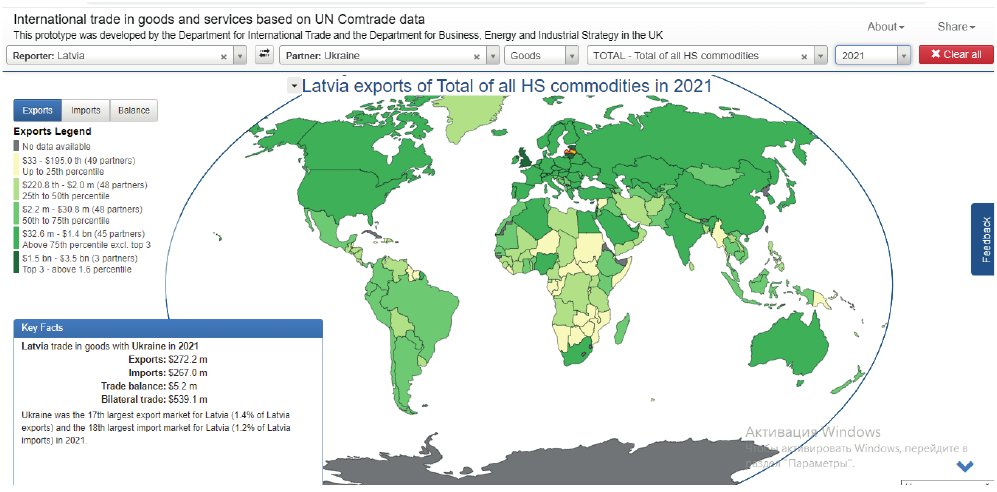
Fig. 2. Key facts about international trade in goods of Latvia and Ukraine in 2021 (United Nations,